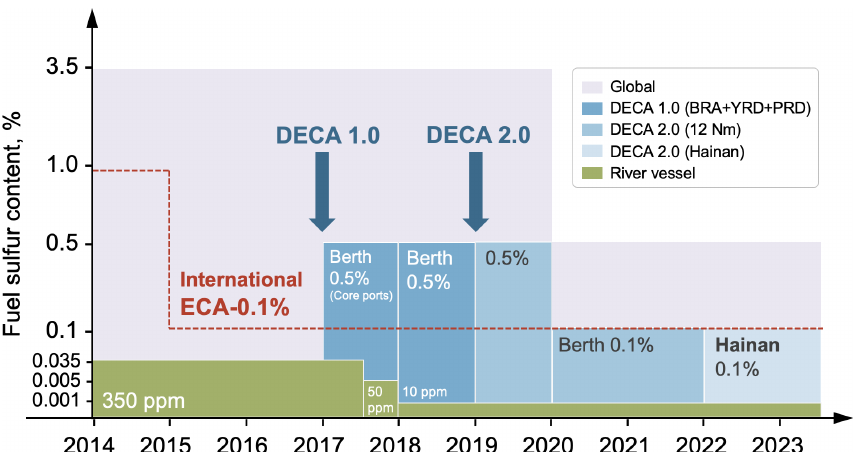
Figure 6. Evolution of sulfur content requirements for fuels in DECAs and inland rivers in China. The percentages refer to the sulfur content of the fuel. The italics refer to the operating mode constrained by DECA policy. The y axis is unevenly distributed to show the standard of fuel sulfur